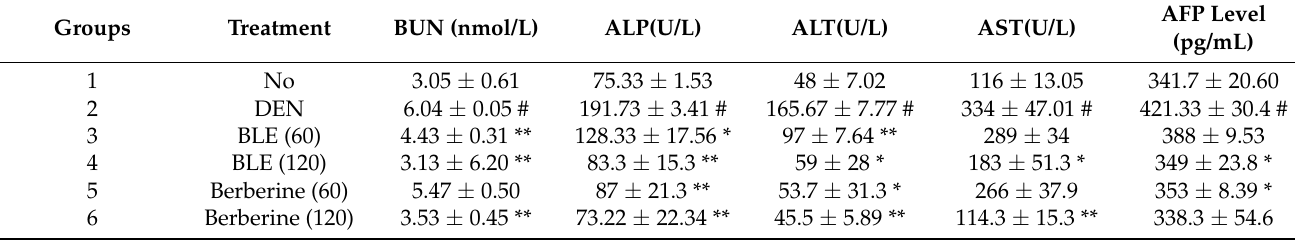
Table 1. Effect of B. lycium Royle alkaloids and berberine chloride on blood urea nitrogen content (BUN), alkaline phosphatase (ALP), alanine aminotransferase (ALT), aspartate aminotransferase (AST) and alpha-fetoprotein (AFP) levels in the blood serum of the